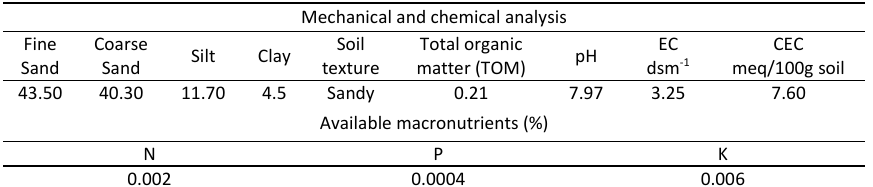
Table 2. Mean values of physical and chemical soil characteristics Mechanical and chemical analysis